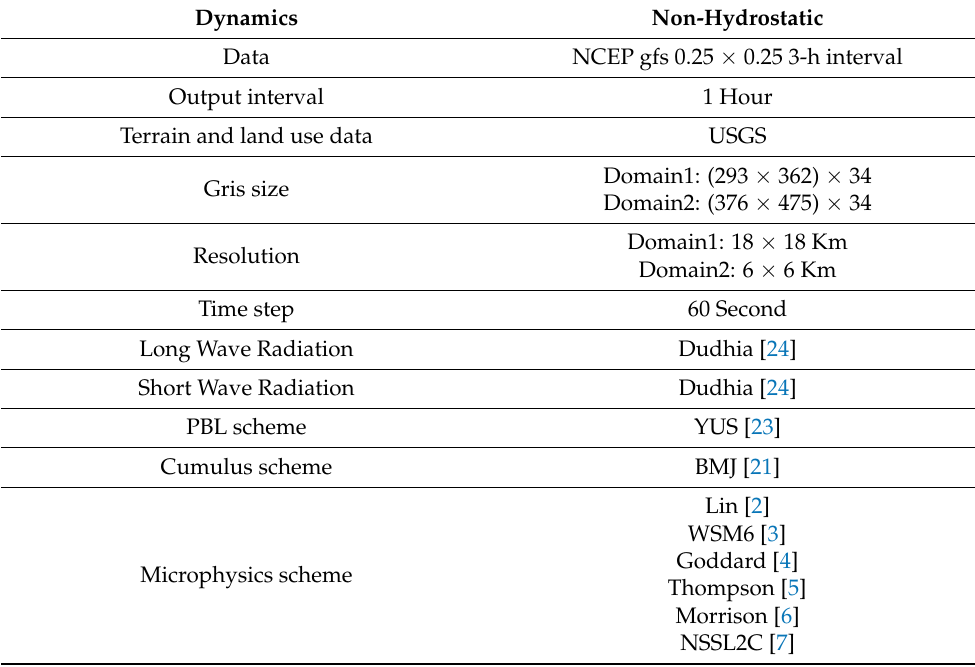
Figure 2. Weather Research and Forecasting (WRF) domains and topography (m). The WRF domains are assigned in black and red polygons. The study area is assigned in red polygons with red closed circles representing synoptic stations showing recorded precipitation on 12 March 2020. Table 4. WRF ARW model